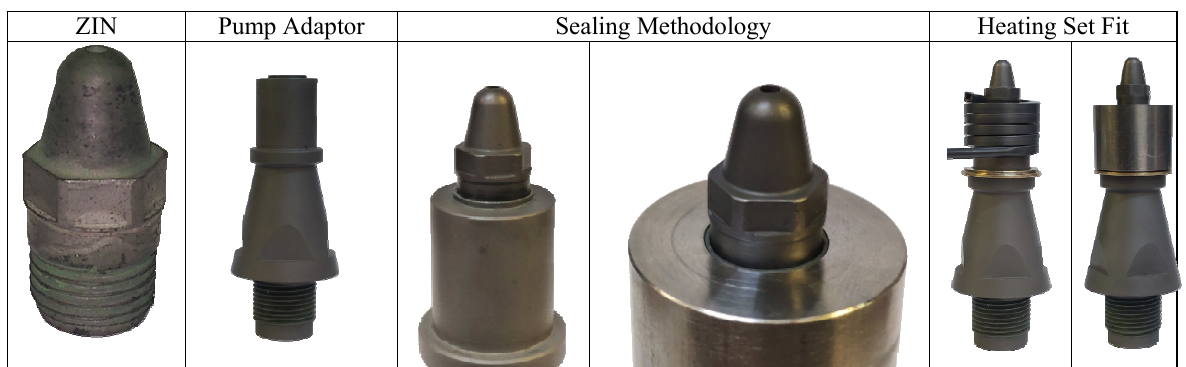
Table 5. New concept of injection